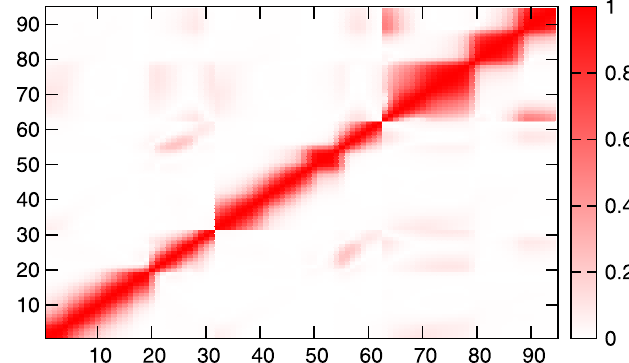
Fig. 5. Correlation matrix of decay heat and b -delayed neutron activity after uranium-235 fi ssion by thermal neutrons.